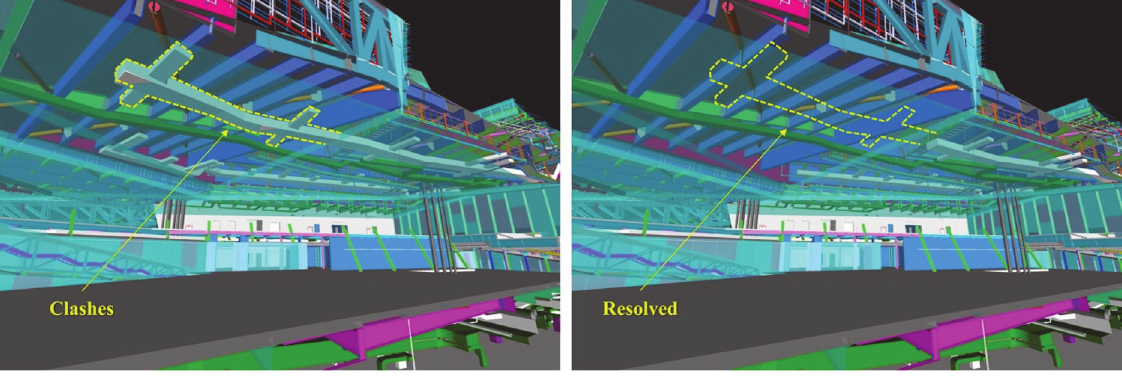
Figure 3. An example of coordination issue (Before and after